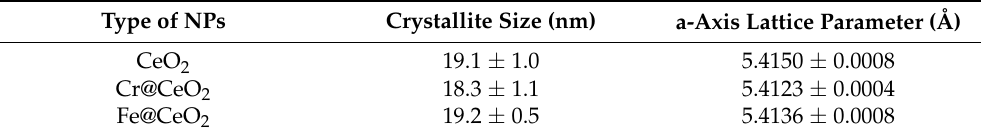
Table 1. Crystallite sizes and lattice constants of the cubic fluorite CeO 2 crystal structure estimated through Pawley refinement for XRD spectra acquired from CeO 2 , Cr@CeO 2 , and Fe@CeO 2 NPs. The error rates indicate the 95% confidence interval. Type of NPs